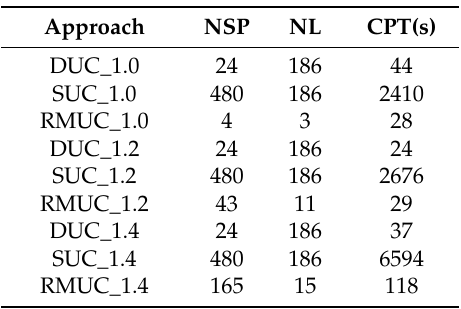
Figure 8. Model scales of different approaches. Table 2. Computing performance of different approaches.